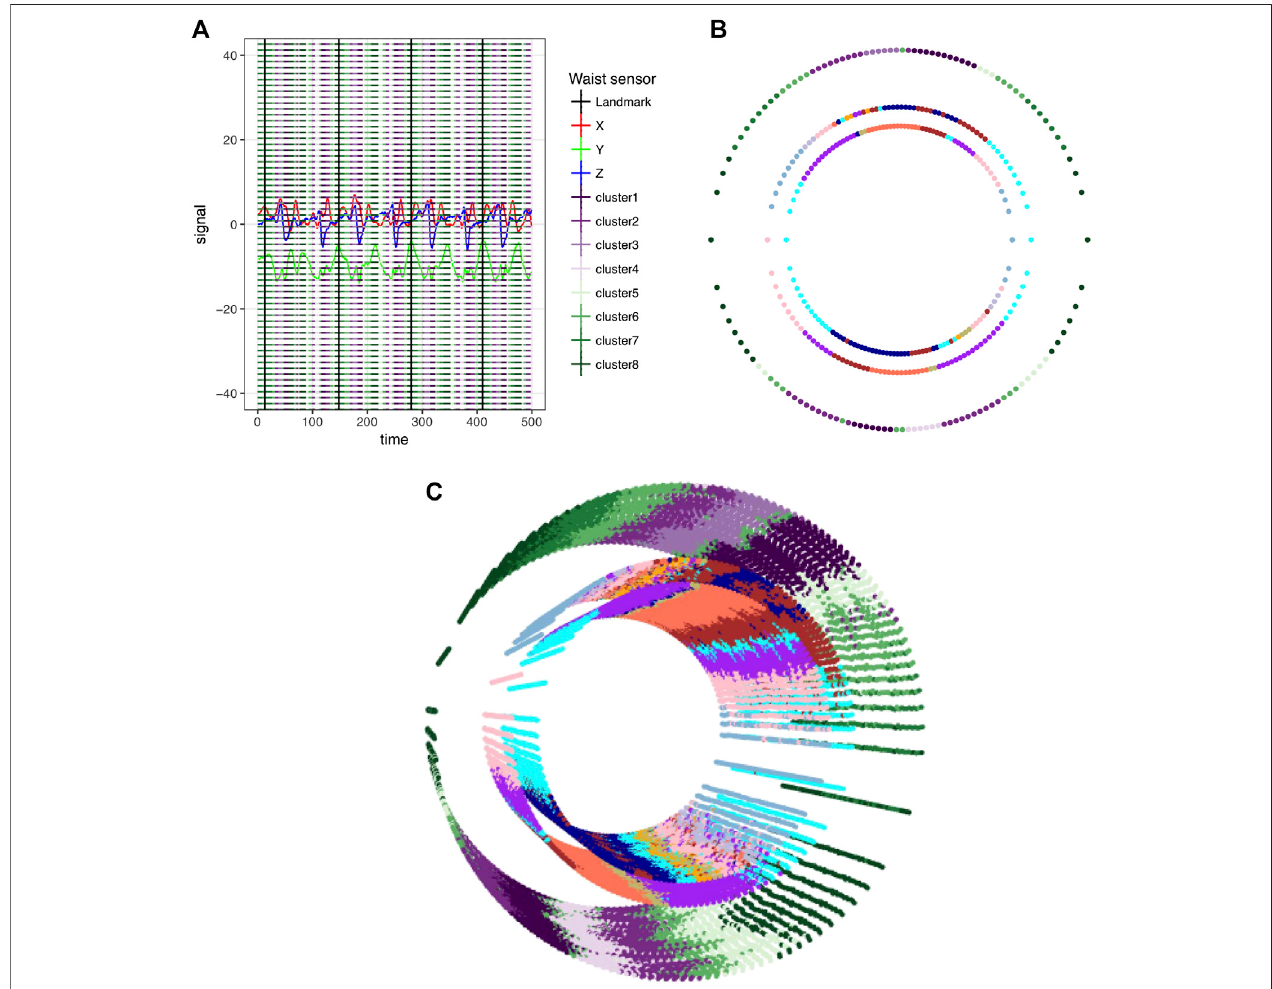
FIGURE 7 | Integrated gait dynamics of waist and L + R system. (A) Color-coded 3D time series from waist with eight clusters resulted from the local coding scheme of L1G2 algorithm. (B) Result of L1G2 algorithm represented by three layers of concentric-ring pertaining to the third rhythmic cycle on the temporal period [ 1 , 10 , 000 ] . (C) 3D cylinder representation of evolution of rhythmic cycles from the third to the 70th of this integrated system of three